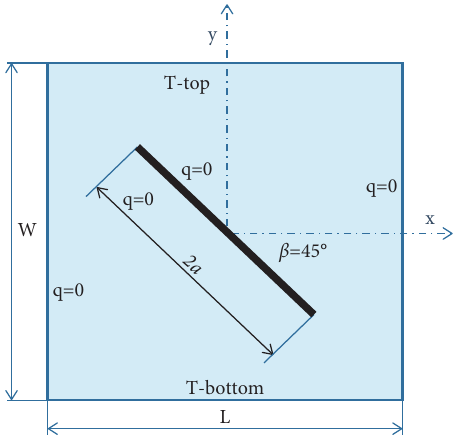
Figure 11: Model geometry and boundary conditions for a square plate with adiabatic inclined crack.